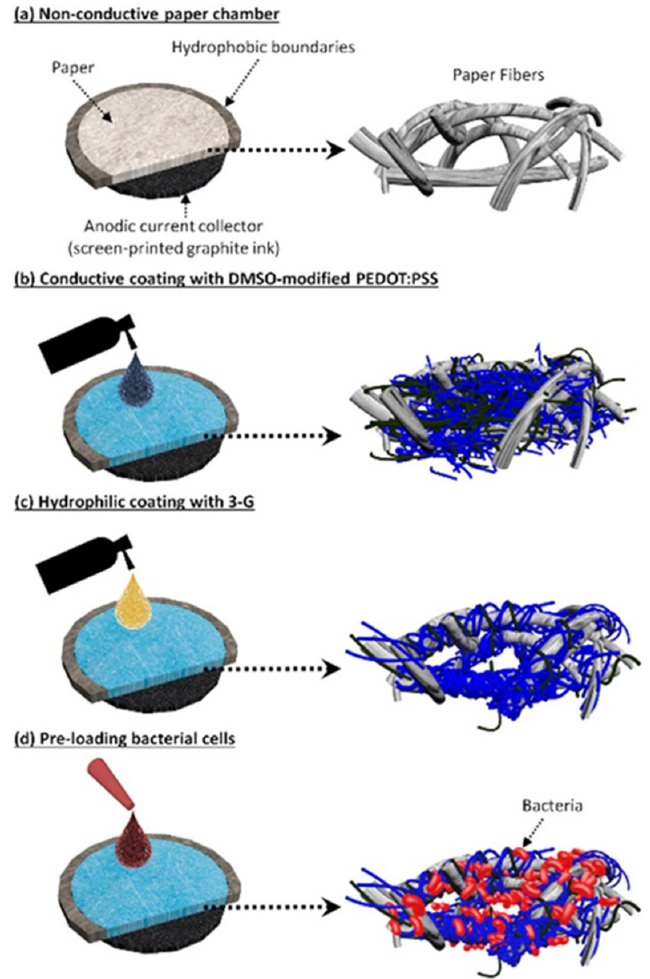
Figure 2. Schematic illustration of the fabrication steps for conductive and hydrophilic anodic chambers. ( a ) Defining Hydrophobic boundaries, ( b ) Conductive engineering the anodic reservoir, ( c ) Hydrophilic coating of the reservoir, and ( d ) pre-loading exoelectrogens.